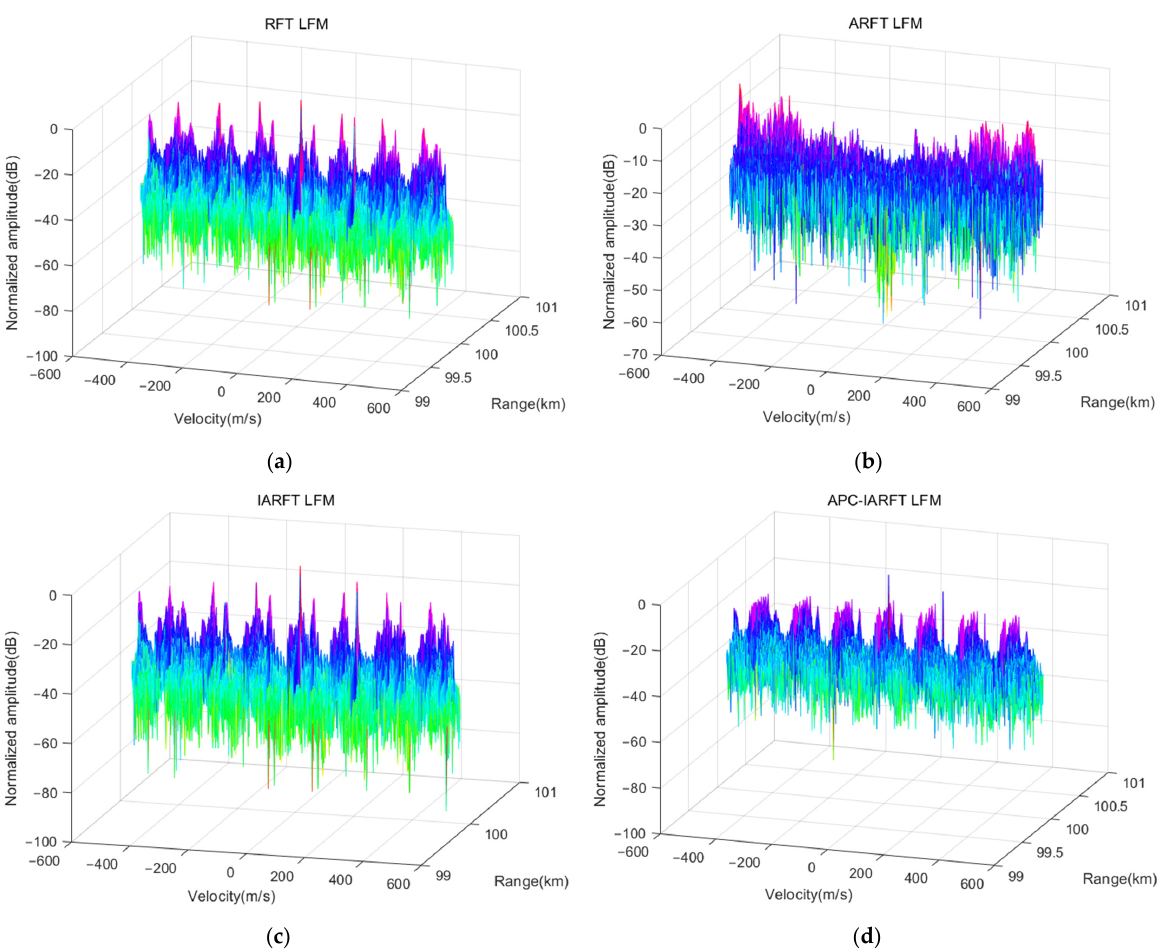
Figure 14. Stereogram output of four methods in Scenario 4. ( a ) Output of RFT; ( b ) Output of ARFT; ( c ) Output of IARFT; ( d ) Output of APC-IARFT.